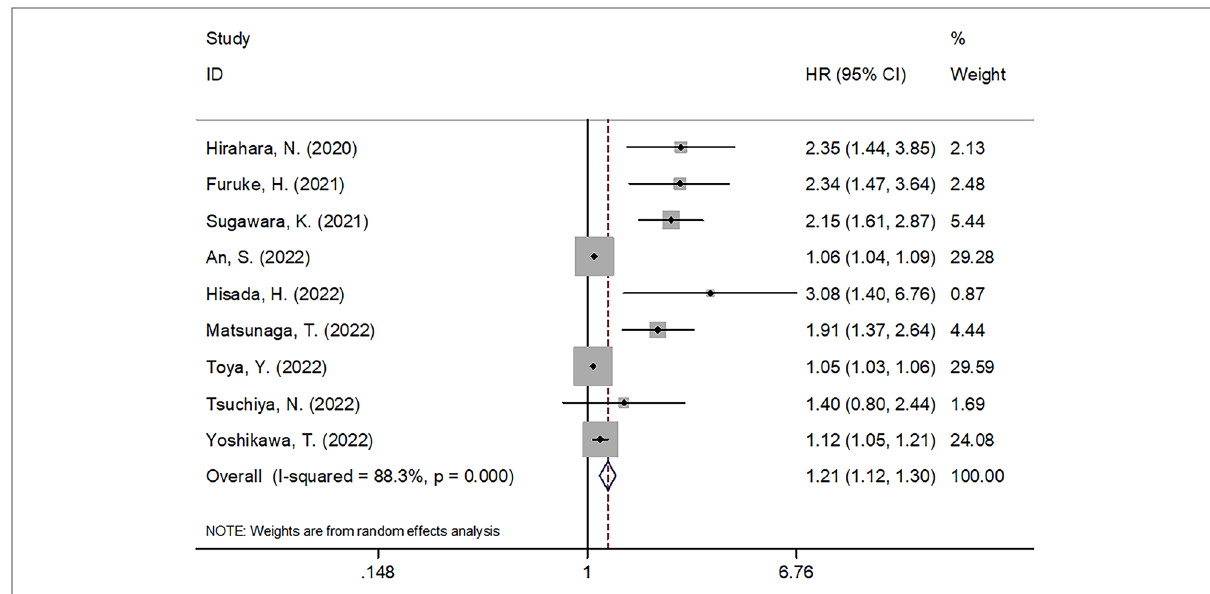
FIGURE 2 Forrest plots of the correlation between GNRI and OS in GC